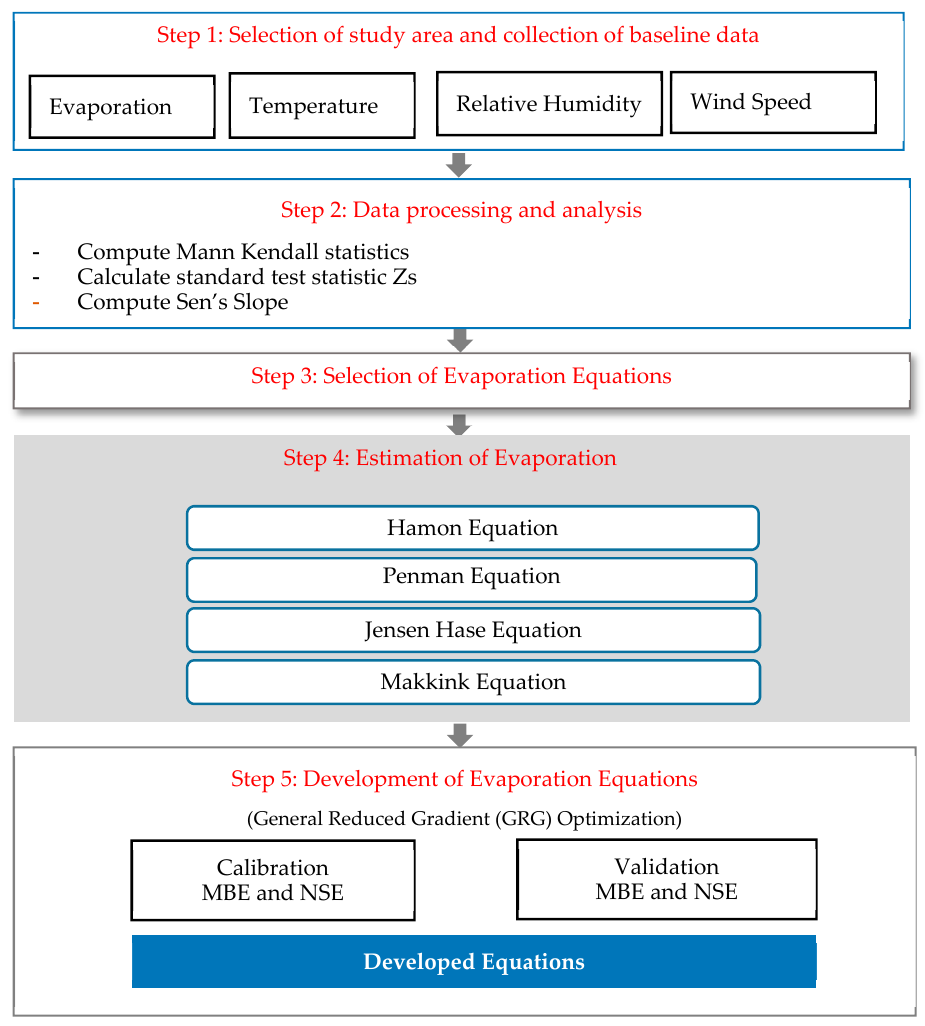
Figure 1. Framework for the methodology.